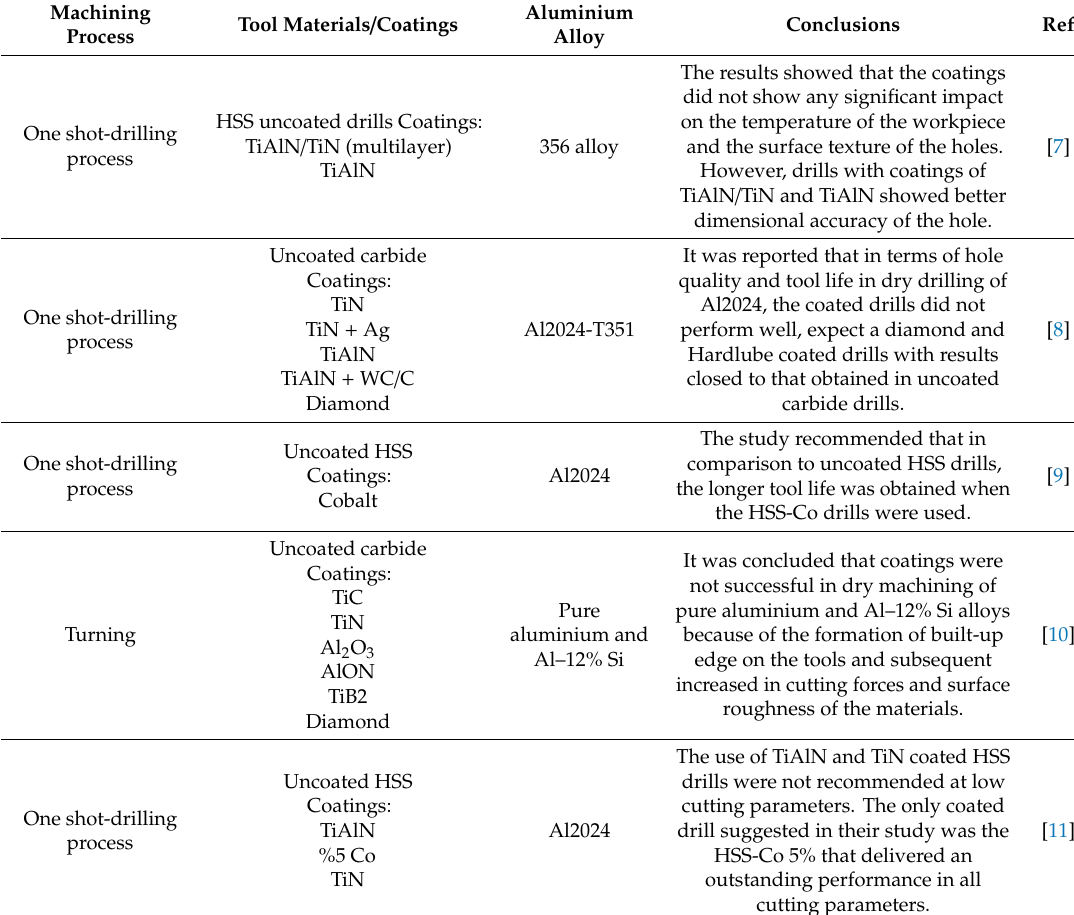
Table 1. Previous studies on the machining of aluminium alloys using coated drill